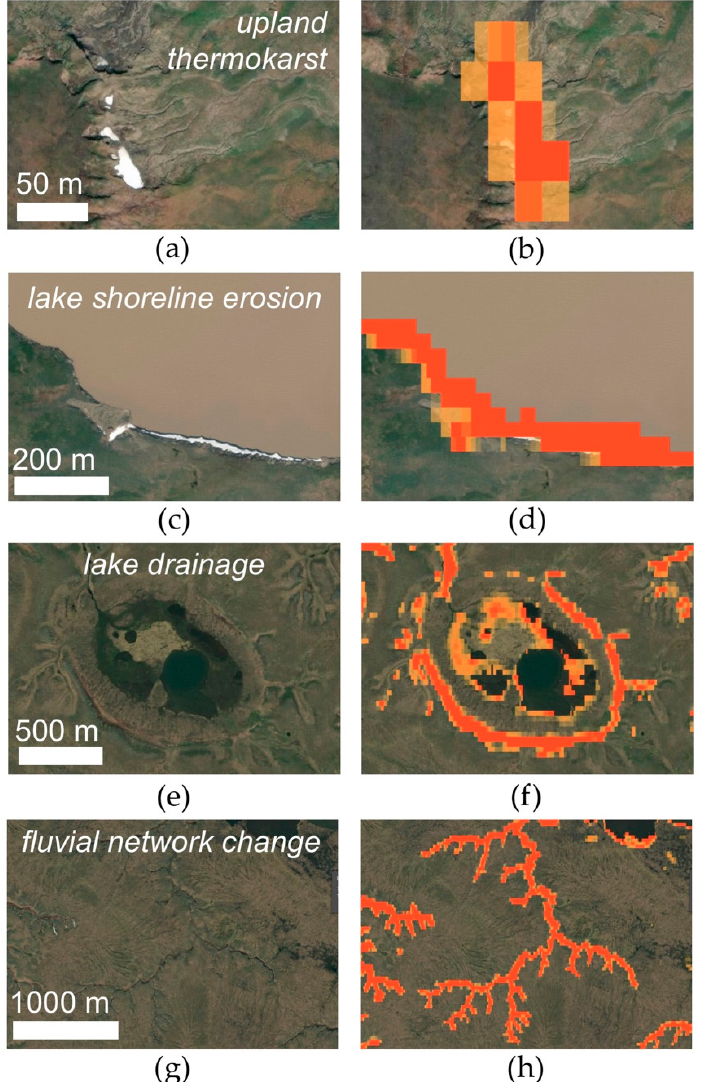
Figure 3. Examples of types of land surface change in the Yamal-Gydan region that were detected by the change detection algorithm (CDA): upland thermokarst ( a ) with change pixels ( b ); lake shoreline erosion ( c , d ); lake drainage ( e , f ); and fluvial network change ( g , h ). Satellite imagery in the left and right columns are identical. Imagery in the right column includes colored pixels from the CDA. Imagery © 2020, DigitalGlobe.